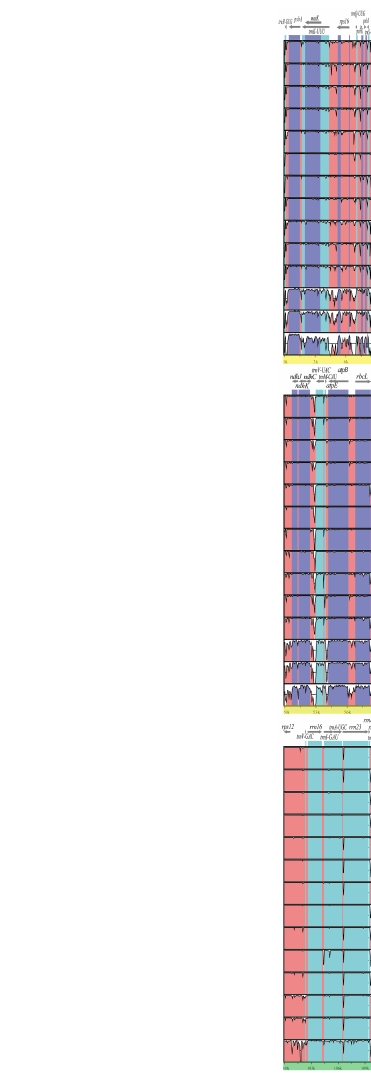
FIGURE 2 Chloroplast genome sequence comparison of 11 Cerasus species, apple, pear, and grape based on mVISTA. The similarity graphical information portrays sequence identity with Prunus pseudocerasus (NC030599) as reference. A cut-off of 50% identity is used for the plots. In each plot, the Y- axis represents percent identity (50 –